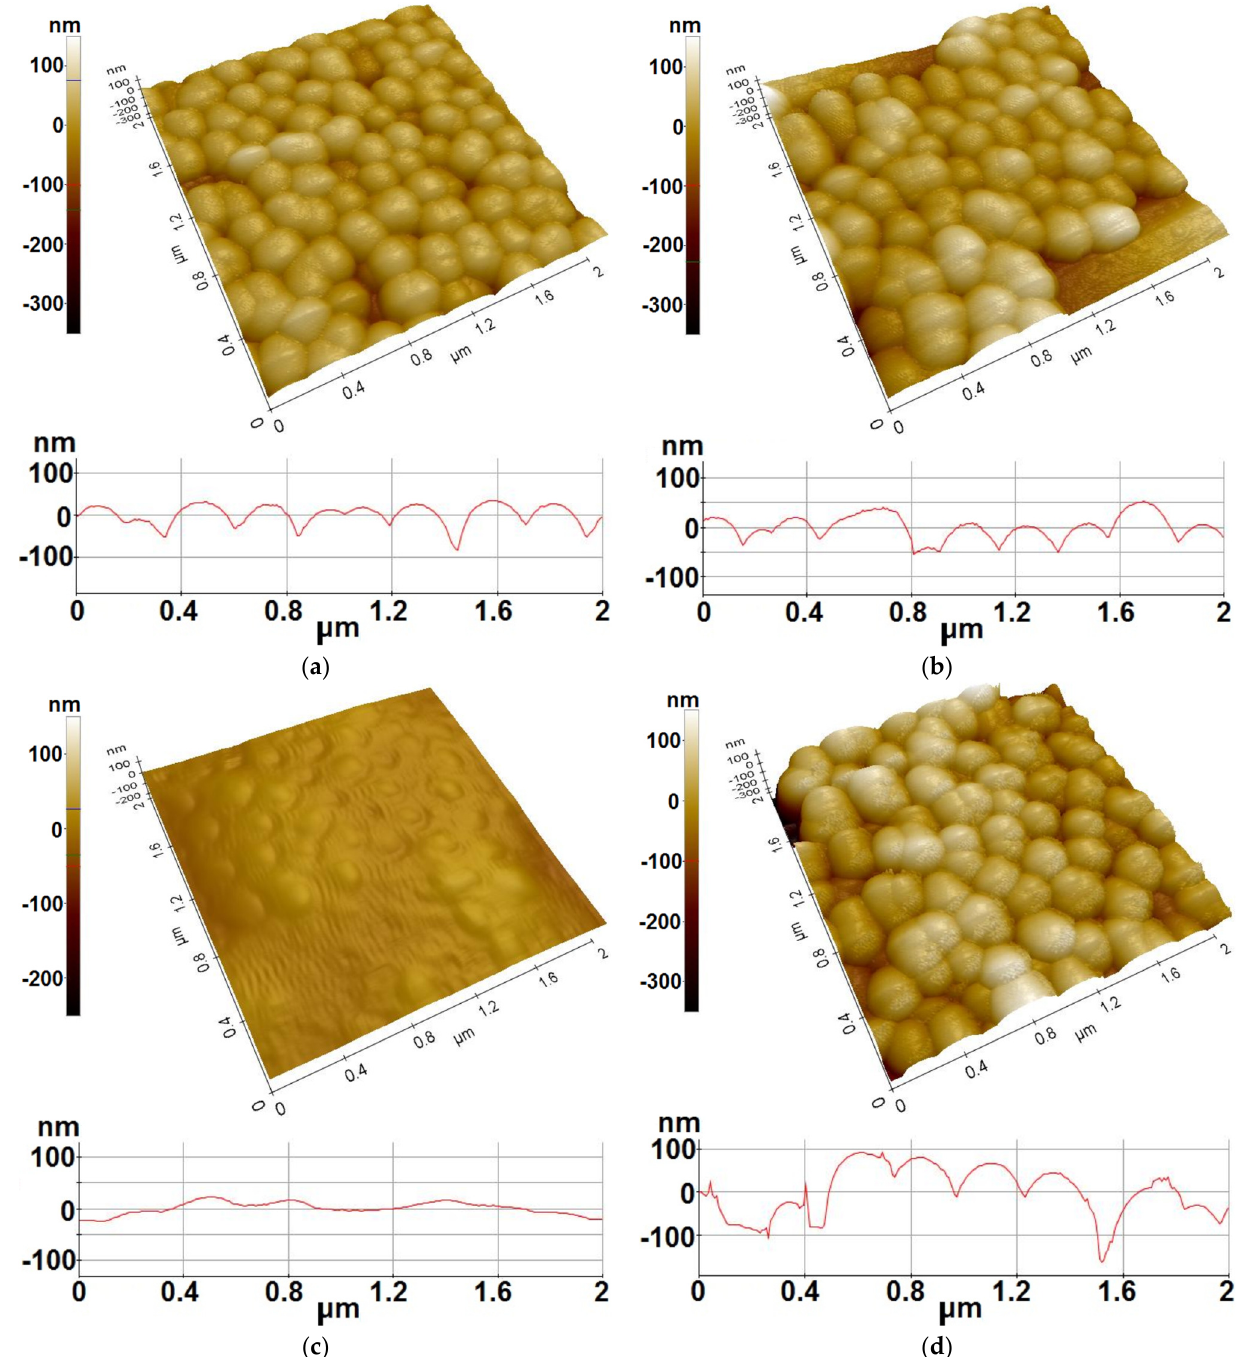
Figure 7. AFM images of silica and organically modified silica. SiO 2 -2 ( a ), SiO 2 -2-Org1 ( b ), SiO 2 -2-Org2 ( c ), and SiO 2 -2-Org3 ( d ).